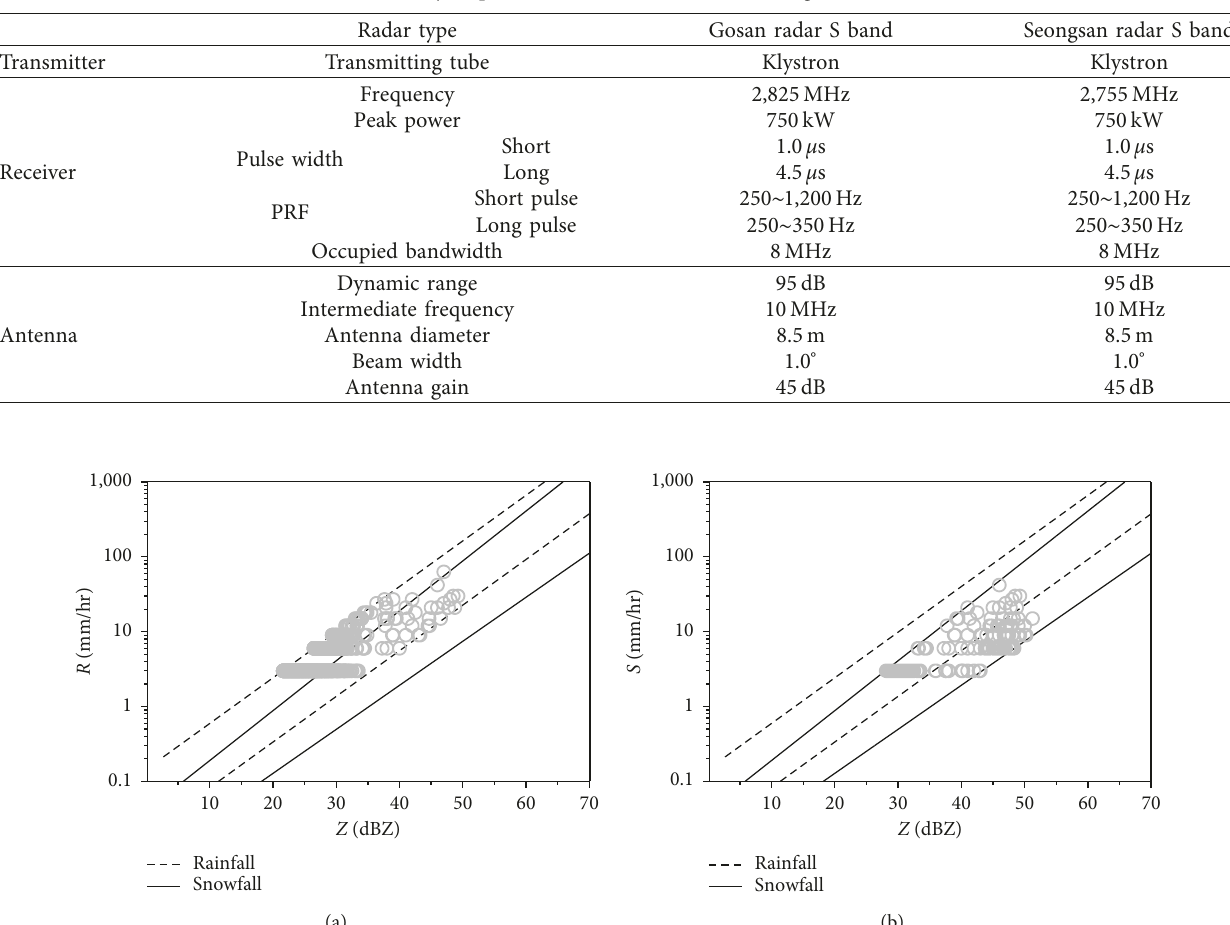
Table 3: Major specification of the Gosan and Seongsan radars.